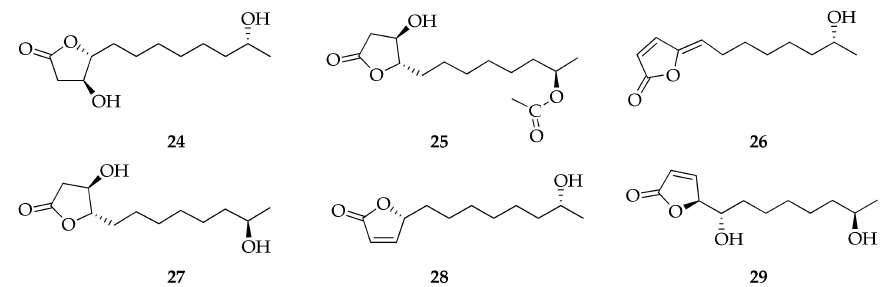
Figure 7. Structures of butanolides and butenolides.